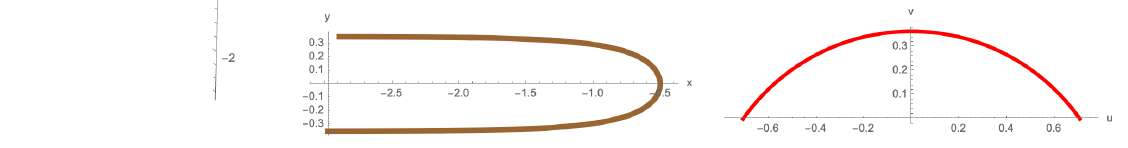
Figure 5. α = 2, ε = 1, q = 1, θ = π